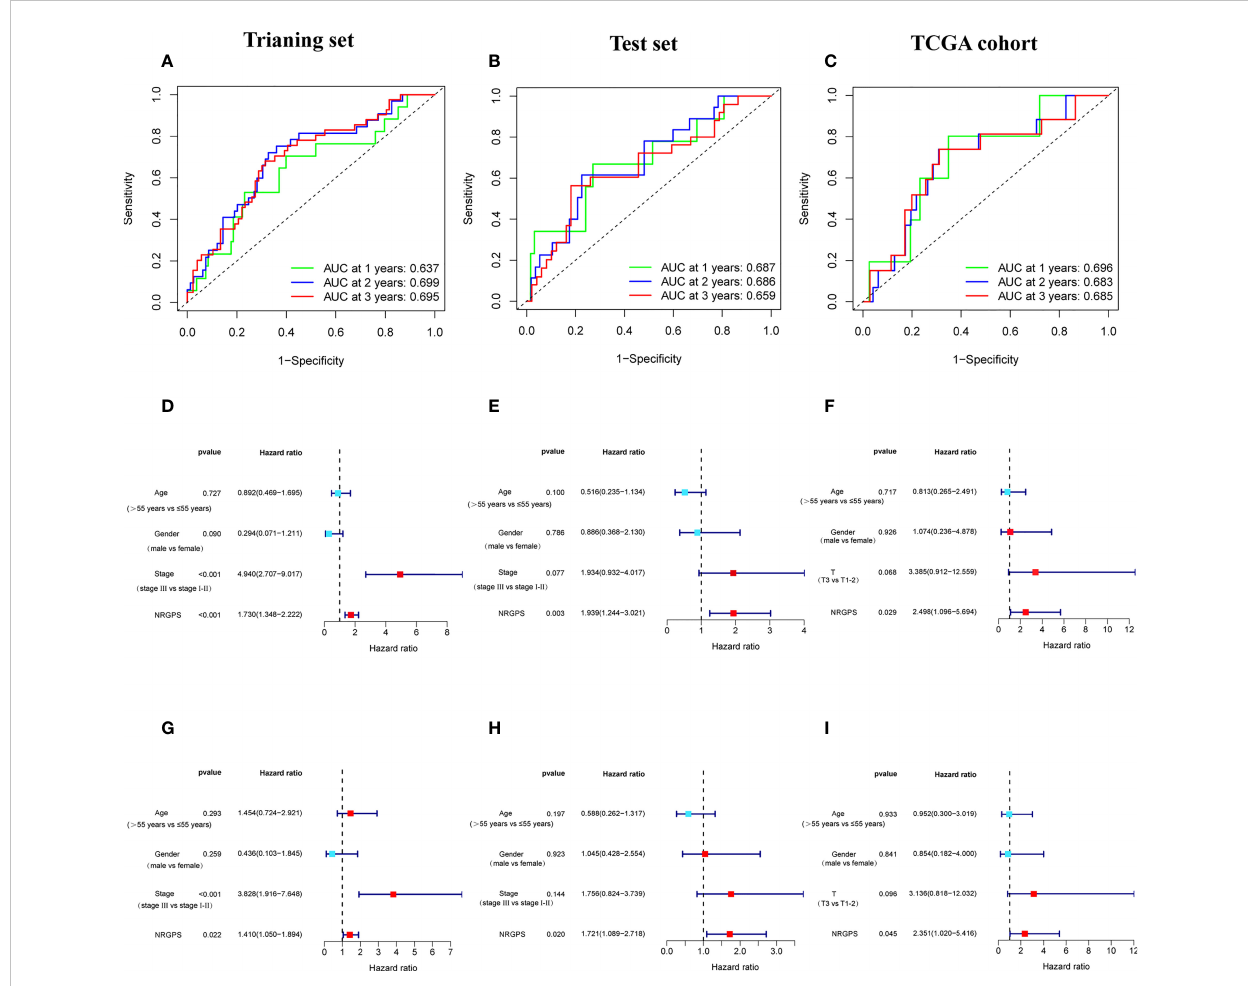
FIGURE 5 Validation of the NRGPS System. (A – C) The ROC curve of Training set, Test set and TCGA cohort veri fi es the prediction ability of this prediction model. (D – I) The Univariable and Multivariable COX regression analyses results of